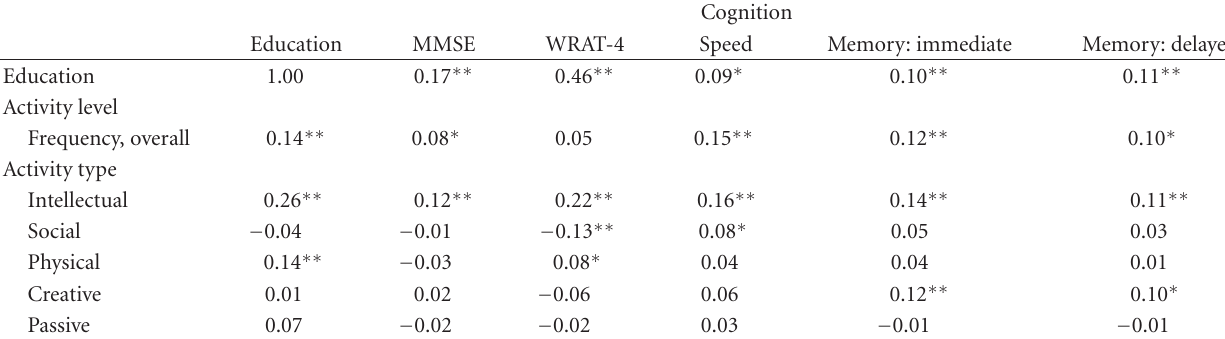
Table 3: Unadjusted correlations among education, activity, and cognition.